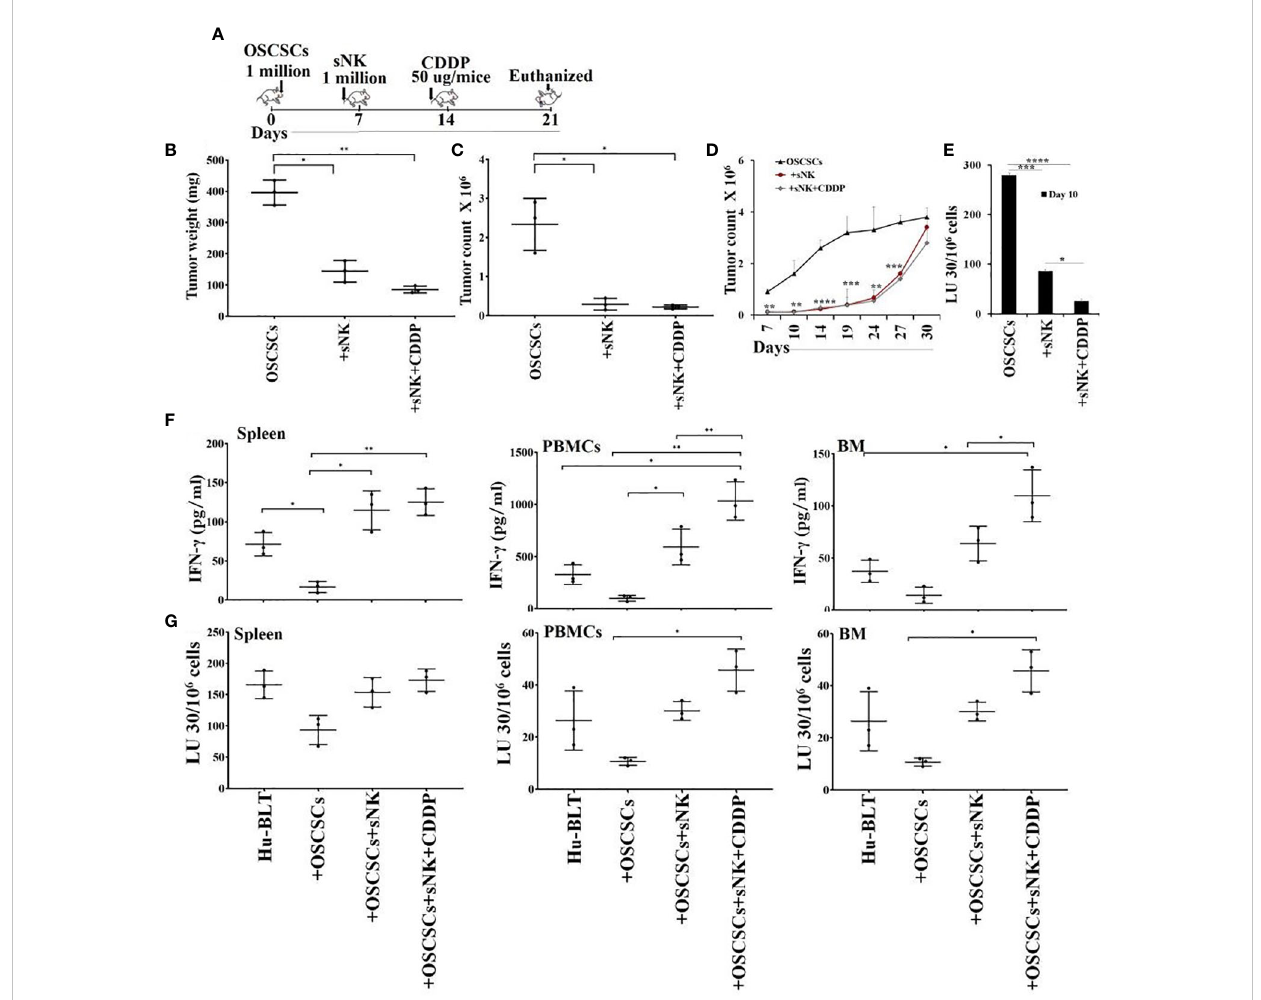
FIGURE 4 Cisplatin mediated decrease in tumor growth when used sequentially with sNK cell treatment in tumor implanted hu-BLT mice, and increased NK cell- mediated cytotoxicity by immune effectors derived from spleen, bone marrow and peripheral blood. Hu-BLT mice were orthotopically implanted with 1 x 10 6 human OSCSCs into the fl oor of the mouth. One week after the tumor implantation, mice received supercharged NK (sNK) cells via tail-vein injection, and one week after sNK cell injection, mice received CDDP (50 µg/mice) via tail vein injection. The disease progression was monitored for another week (A) . Hu-BLT mice were implanted with OSCSC tumors and were injected with sNK cells and CDDP sequentially as depicted in Figure 4A. At the end of experiment, hu-BLT mice were sacri fi ced; the tumors were harvested and weighed (n=3) (B) . Hu-BLT mice were implanted with OSCSC tumors and, were injected with sNK cells and CDDP sequentially as depicted in Figure 4A. At the end of the experiment, hu-BLT mice were sacri fi ced; the tumors were harvested, and the single-cells were obtained as described in the Materials and Methods section. Tumor cells were counted microscopically (n=3) (C) . Hu-BLT derived tumors were cultured at 1.5 x 10 5 / ml at the initiation of the cultures. On day 3, unattached cells were removed and fresh media was added. Tumors were detached and counted on days 7, 10, 14, 19, 24, 27, and 30, each time 1 x 10 5 / ml cells were cultured (n=3) (D) . NK cells (1 x 10 6/ ml) from healthy human donors were treated with IL-2 (1000 U/mL) for 18 hours before they were added to 51 Cr labeled hu-BLT derived tumors at various effector to target ratios. NK-mediated cytotoxicity was determined using 4-hour 51 Cr release